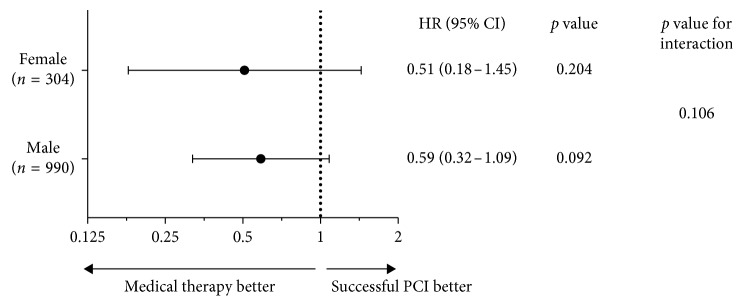
Sex subgroup analysis for cardiovascular mortality. CI, confidence interval(s); HR, hazard ratio; PCI, percutaneous coronary intervention.